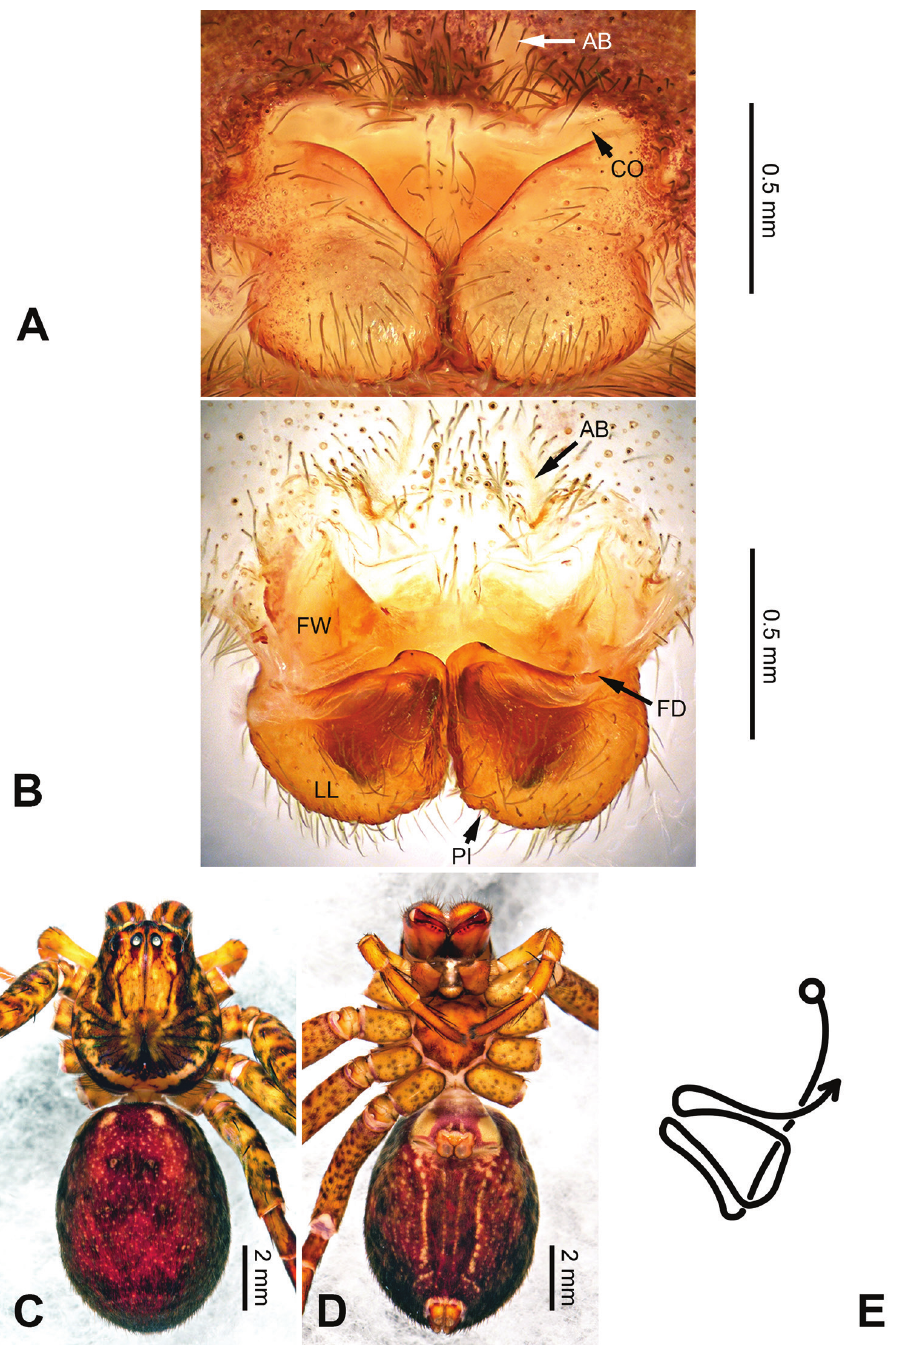
Figure 27. Pseudopoda subbirmanica Zhao & Li, sp. n., paratype female. A Epigyne, ventral view B Vulva, dor- sal view C Habitus, dorsal view D Habitus, ventral view E Schematic course of internal duct system, dorsal